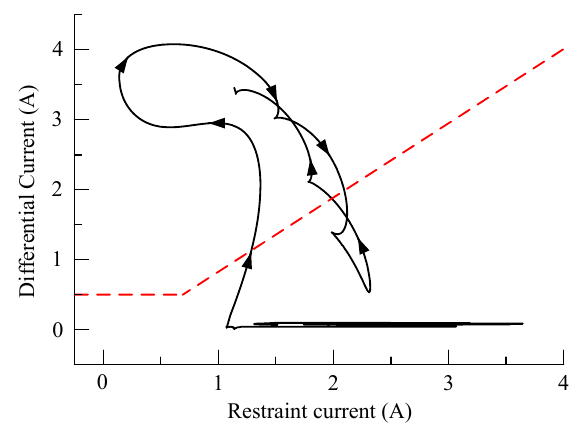
Figure 8. Differential current and restraint